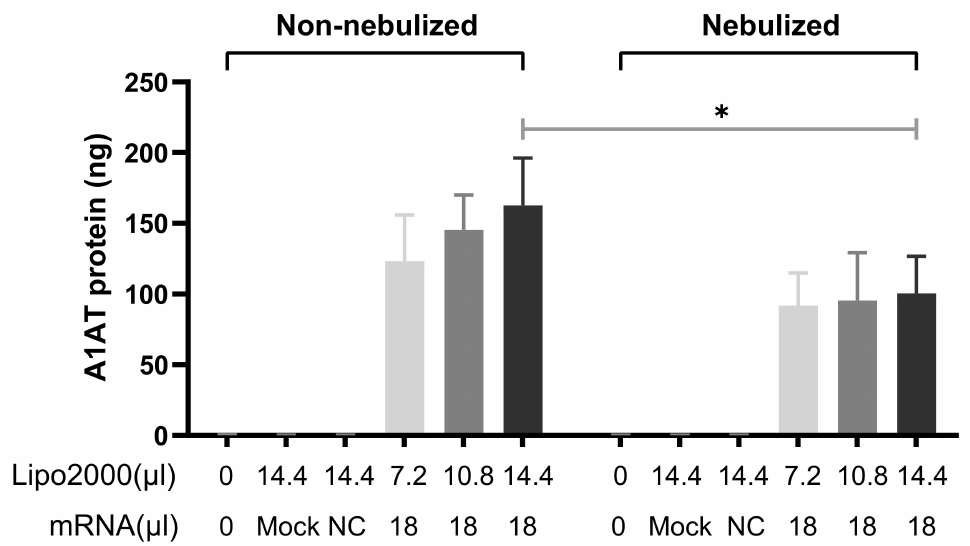
Figure 8. Nanograms of secreted A1AT after transfection with nebulized and non-nebulized A1AT- mRNA/Lipofectamine2000 complexes. Totals of 7.2 µ L, 10.8 µ L or 14.4 µ L Lipofectamine2000